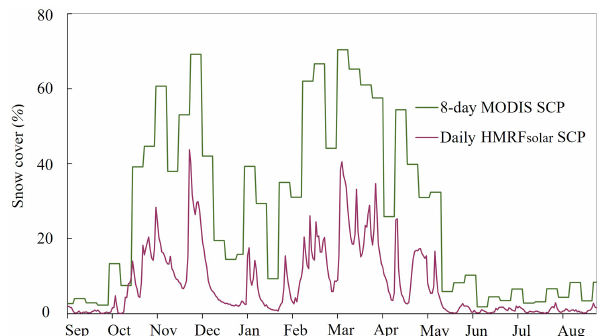
Figure 9. Snow cover percentage for daily HMRF solar -based snow cover products and 8d composite MODIS snow products in a sam- ple area during the 2017 snow season of the TP. (SCP stands for snow cover